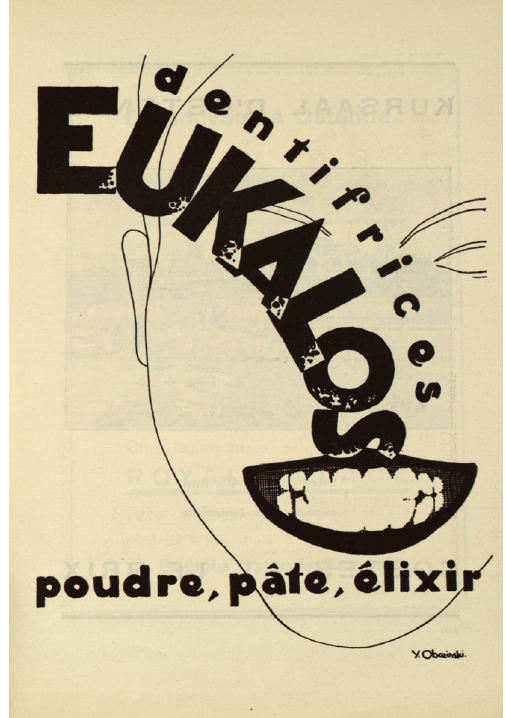
Fig. 10 Variétés , no. 1 (15 May 1928), pl. XXI. Reproduction of a poster by Yvan Obozinski, 1927, colour